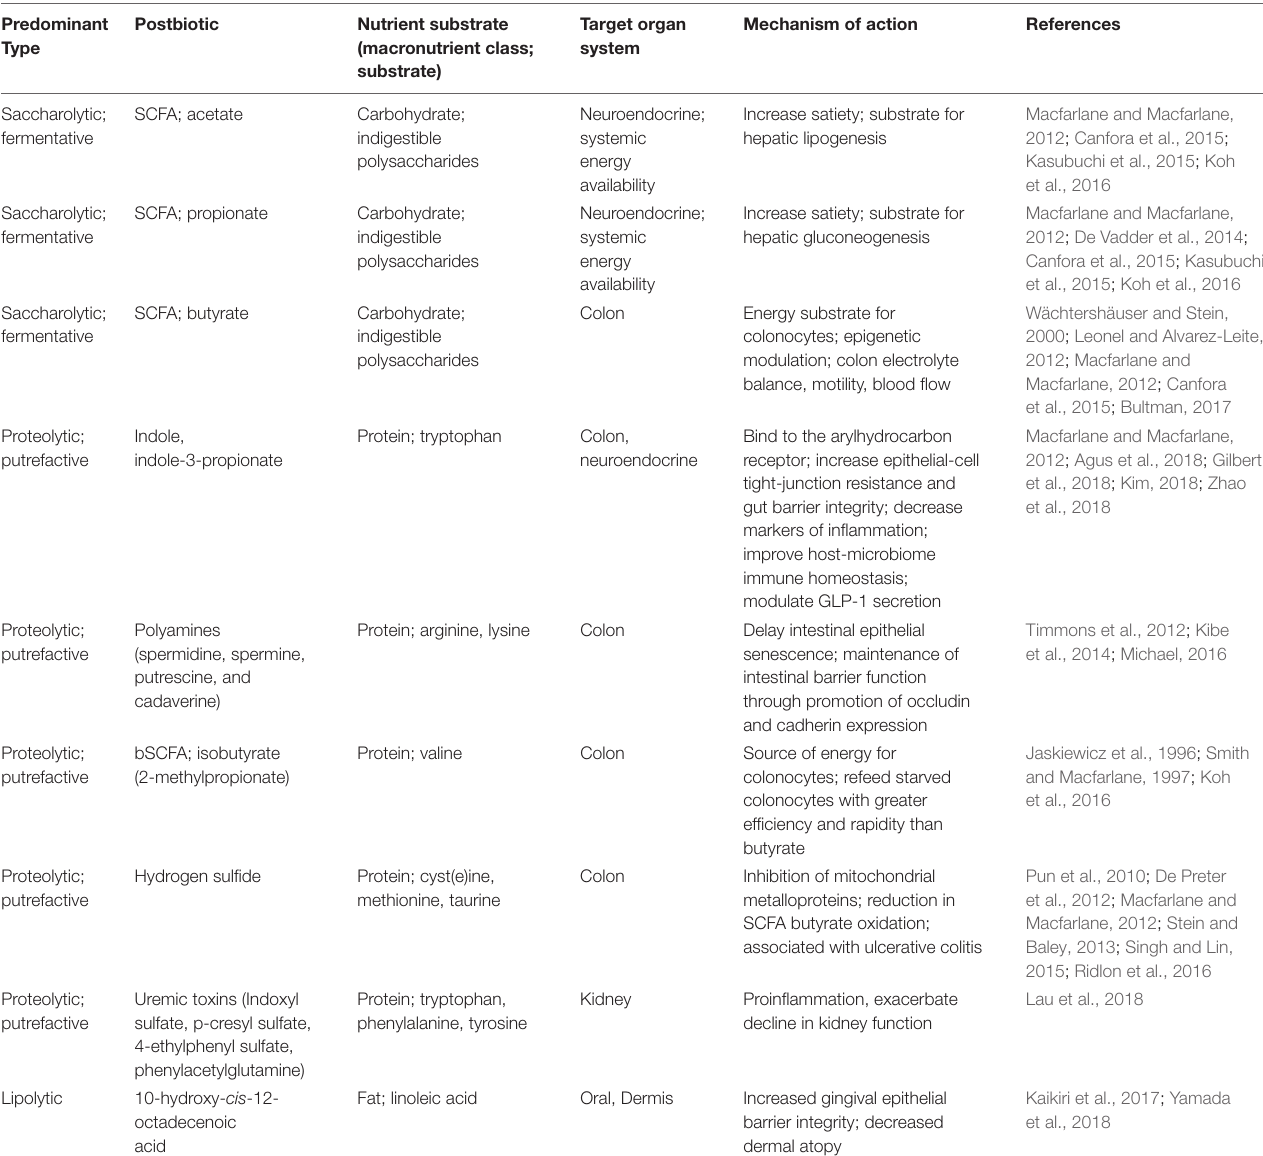
TABLE 1 | Examples of postbiotics that may impact pet